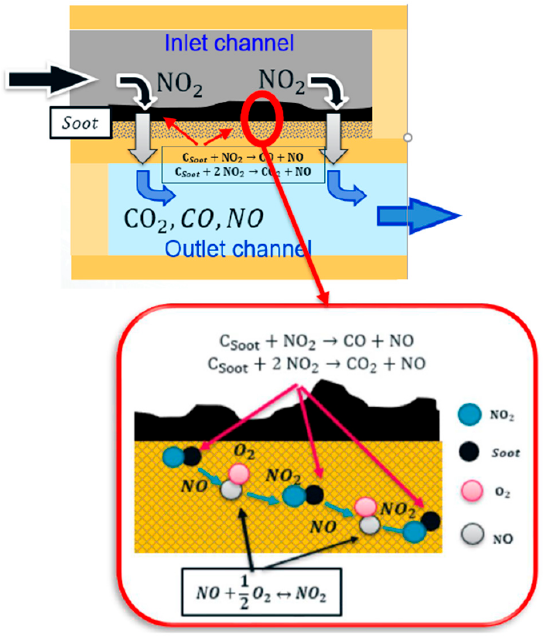
Figure 13. DPF—NO 2 recycling.